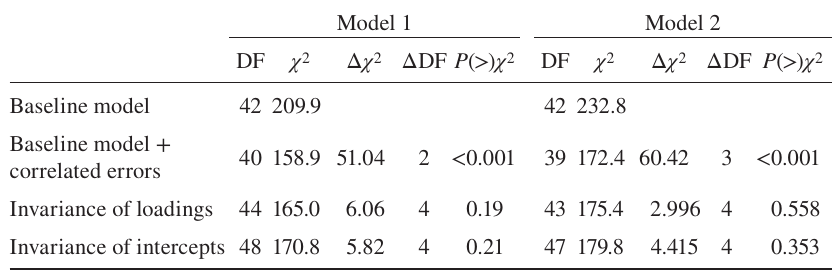
Likelihood ratio test - Within subject measurement equivalence in Dutch and a second